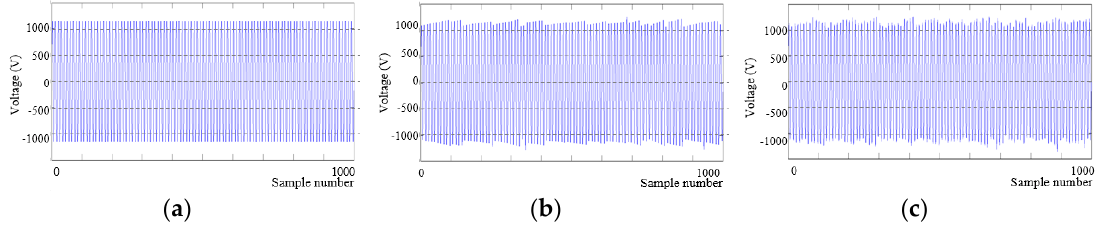
Figure 10. Example explaining the effects of supply voltage variations by using a sine wave. ( a ) A raw sine signal, ( b ) a signal in which distortions caused by supply voltage variations were reflected, and ( c ) a modified signal by adding noise to the signal b.